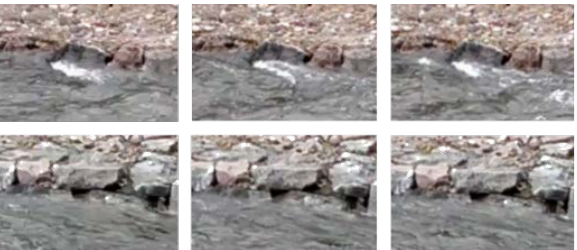
Figure 2: Variability of flowing river shorelines in detail: Image frames 01, 13 & 25 of short-time image sequence (from left to right)